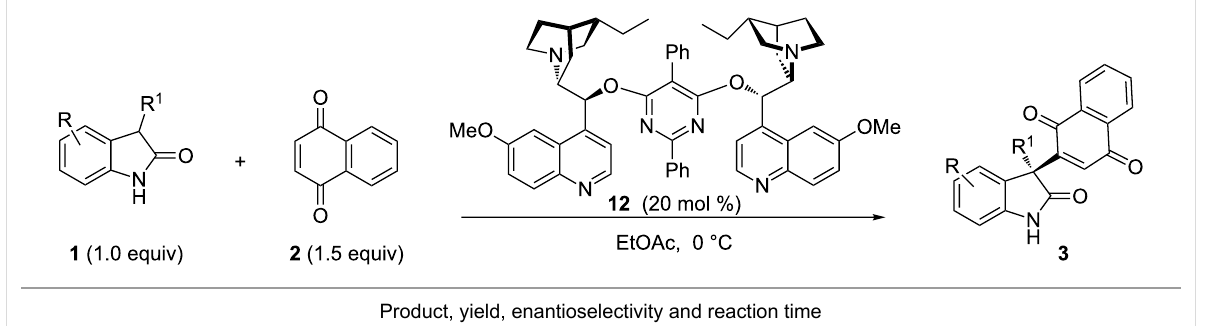
Product, yield, enantioselectivity and reaction